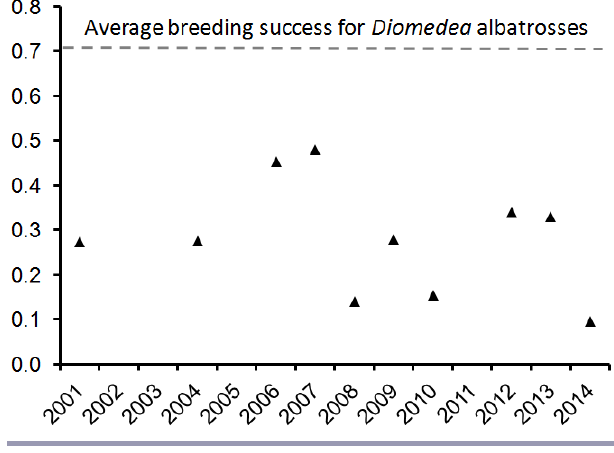
Fig. 6 . Estimates of island wide breeding success for the Tristan Albatross ( Diomedea dabbenena ) from 2001 - 2014 (n = 10 years; total number of island wide incubating pairs ranged from 1271 - 2400; no data for years 2002, 2003, 2005, 2011) compared to the average breeding success for Diomedea spp. albatrosses (Tickell